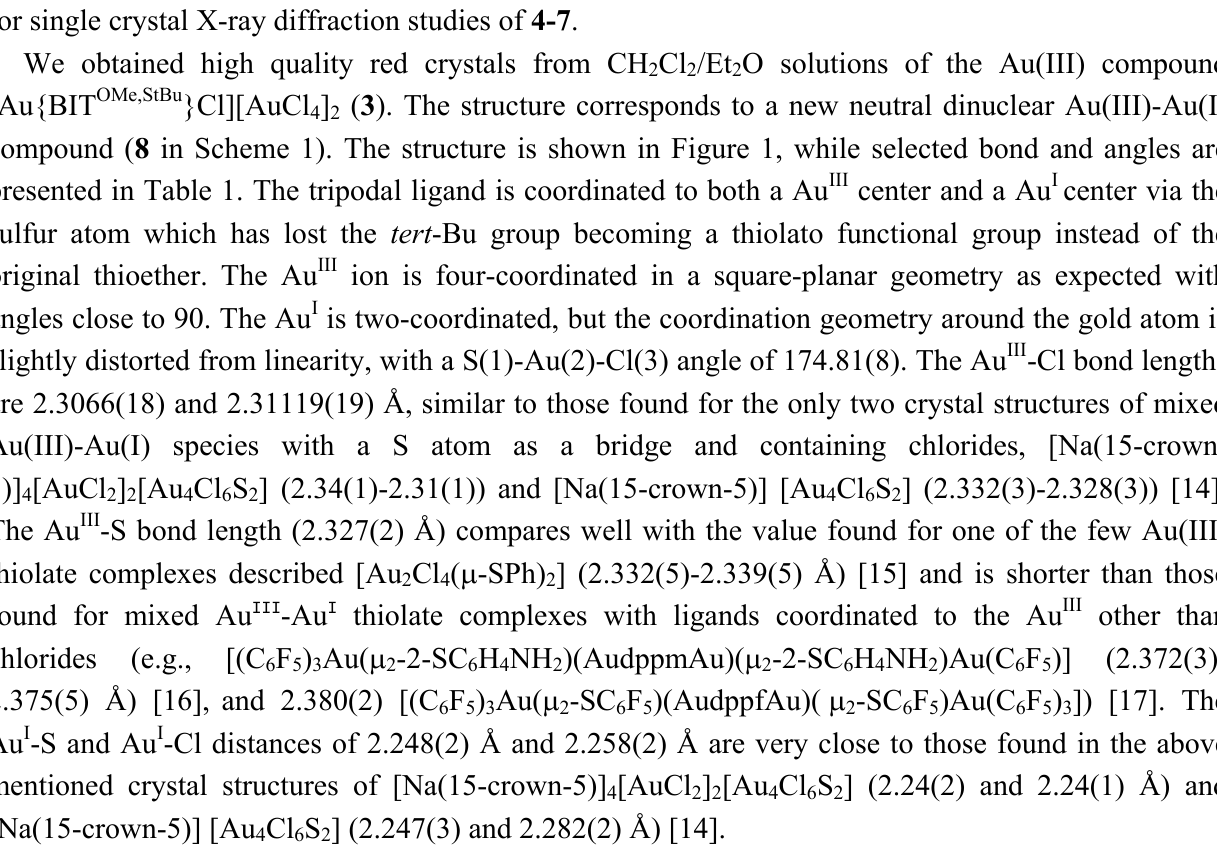
Figure 1. Molecular drawing of neutral dinuclear mixed Au III -Au I species [Au {BIT OMe,S }Cl ] 8 (obtained while crystallizing compound[Au{BIT OMe,StBu }Cl][AuCl 2 3 3 ) with the atomic numbering